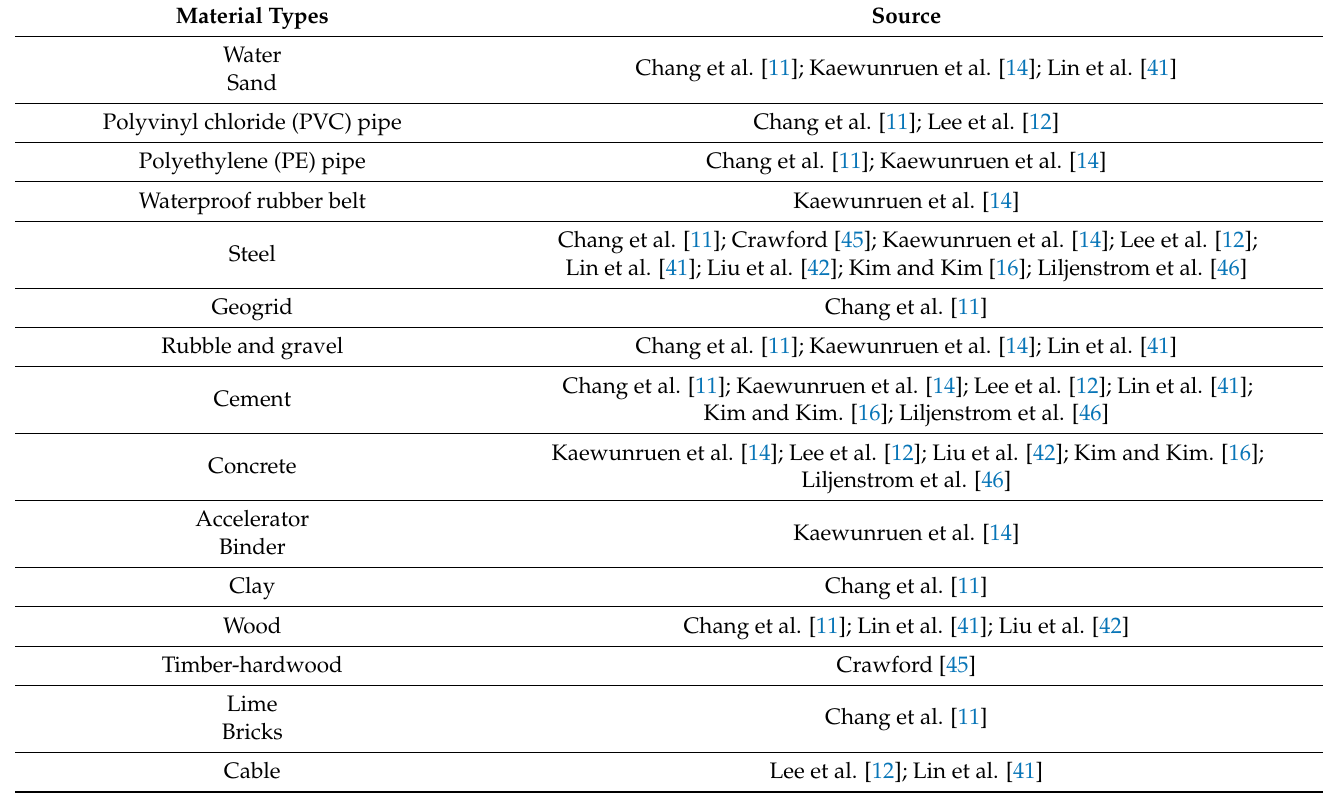
Table 2. Building materials CEFs based on